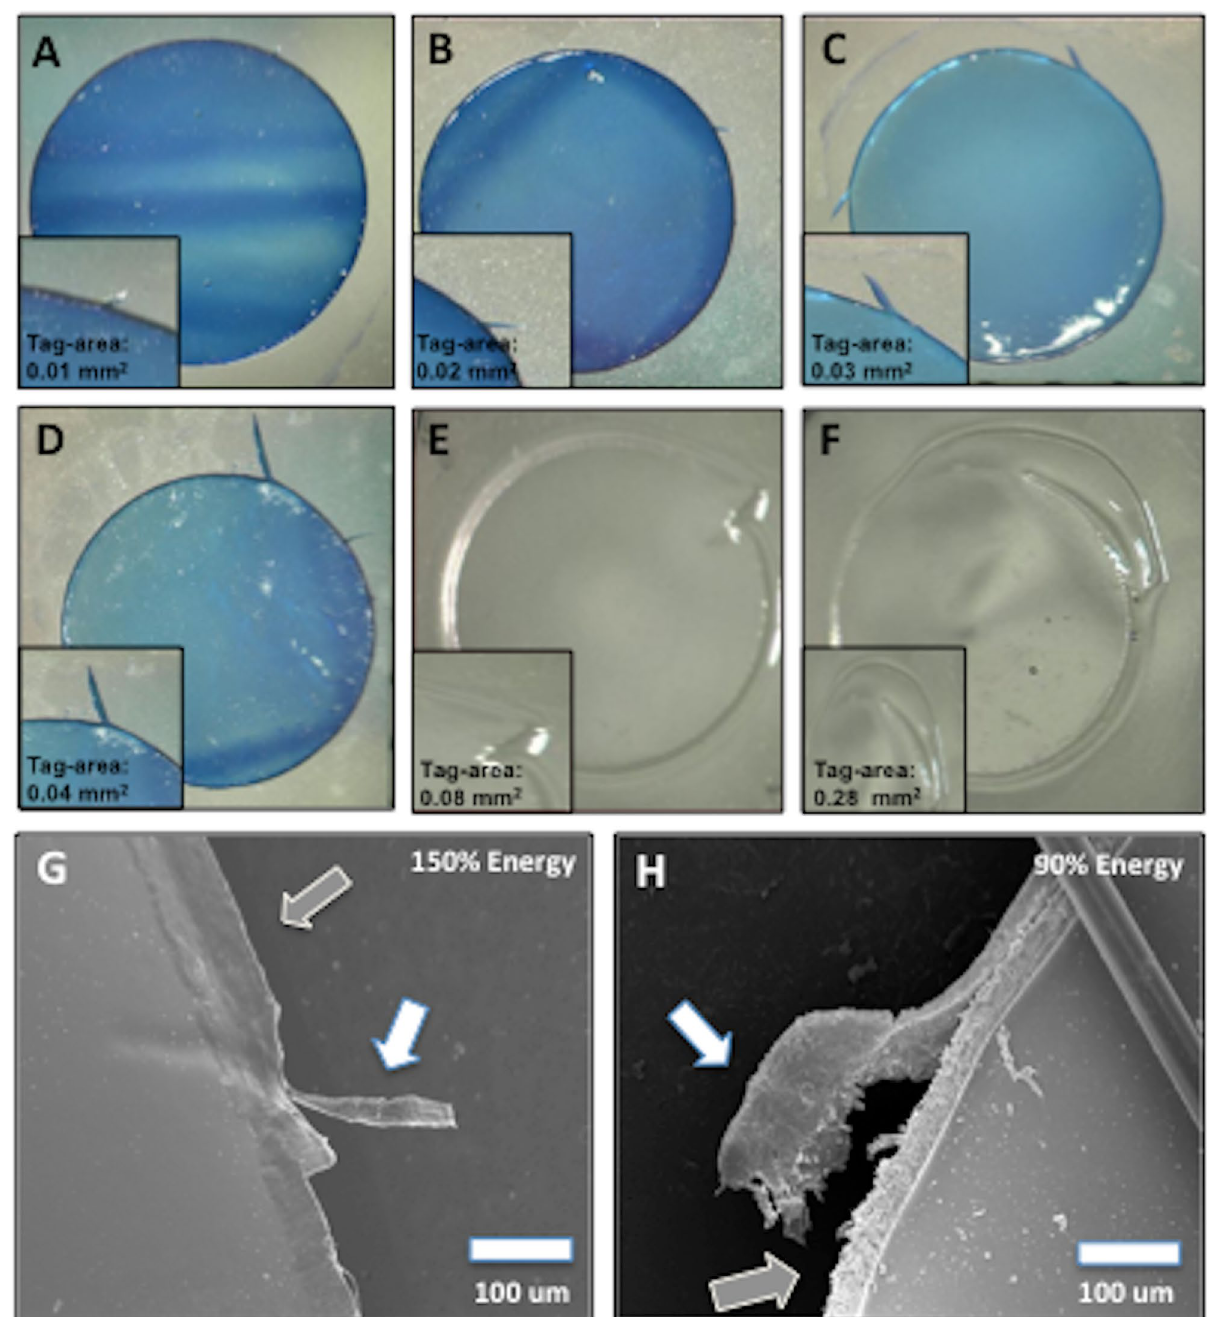
Figure 4. Lens capsules showing severity of a capsular-tag based on tag-area and SEM images of capsule edge morphology. ( A , B ) Complete laser-cut with macroadhesion. ( C , D ) Incomplete laser-cut with macroadhesions. ( E , F ) Non-continuous/irregular laser-cut showing worst tag-area. ( G , H ) High magnification (× 1000) SEM images of capsule-edge. The white arrow highlights the ( G ) small-tag and ( H ) big-tag respectively. The grey arrow shows the ( G ) relatively smooth and ( H ) rough capsule edge, seen with 150% and 90% energy settings, SEM imaging. The capsular tags were visible on SEM (Fig. 4G,H). The use of a lower energy setting in the presence of an OVD in the AC, regardless of its type, produced a rougher and a more irregular capsular edge compared to an edge achieved with a higher energy setting (Fig. 4).